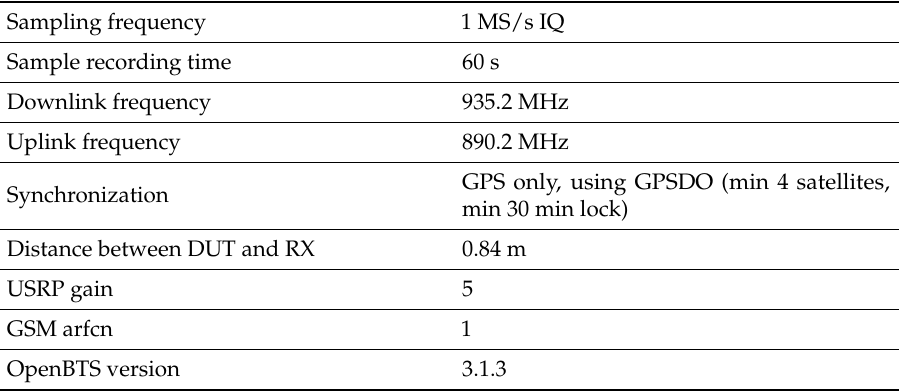
Table 1. Parameters for signal collection.